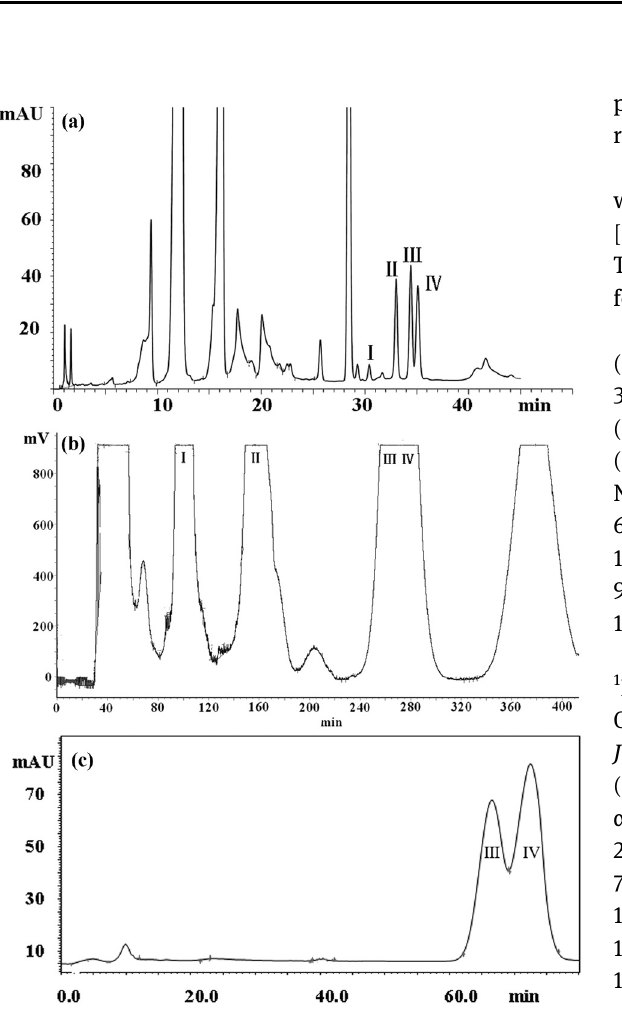
Figure 3: Chromatograms. ( a ) Crude extracts of R. tanguticum by SWE; ( b ) HSCCC chromatogram of the sample using the chloroform/ methanol/water ( 5:3:4, v/v ) solvent system; ( c ) prep - HPLC separation of compounds III and IV; compounds I, II, III, and IV were emodin - 1 - O - β - D - glucoside, physcion - 8 - O - β - D - glucopyranoside, chrysophanol - 1 - O - β - D - glucoside, and chrysophanol - 8 - O - β - D - glu - coside,